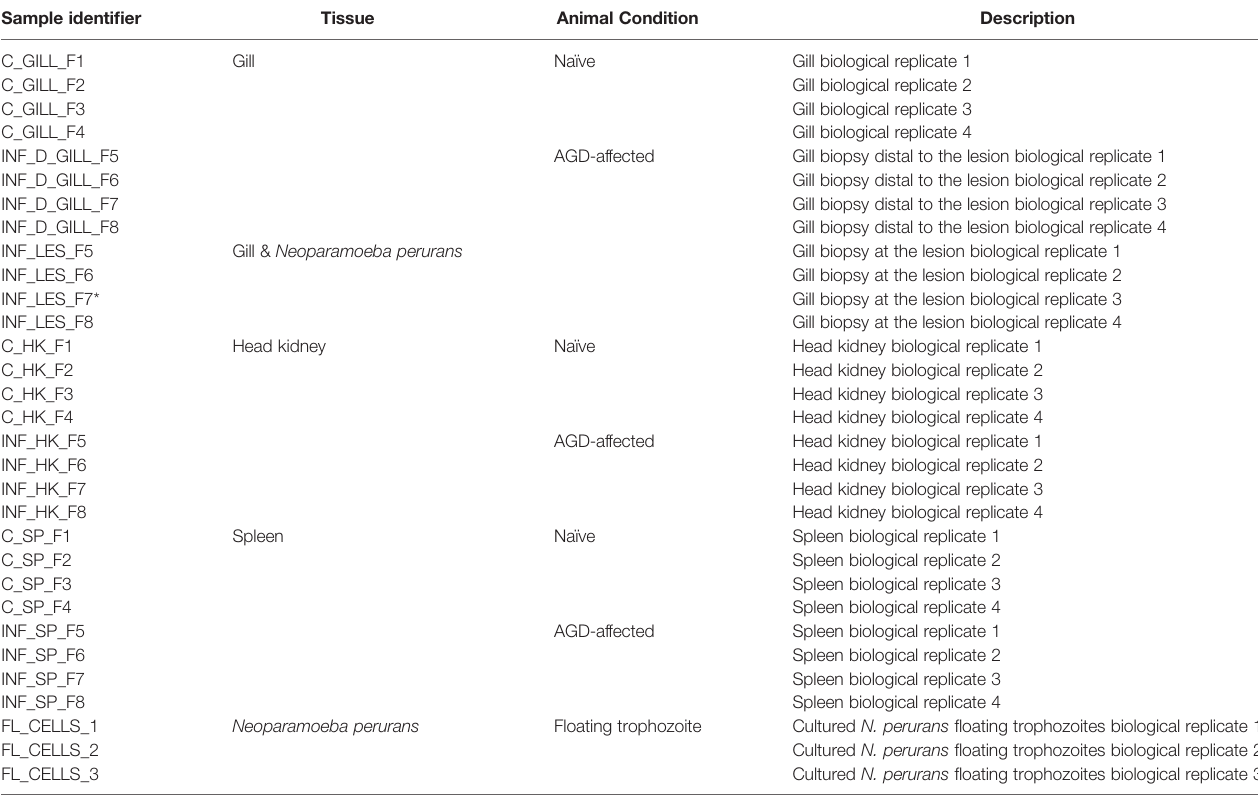
TABLE 1 | Attributes of samples collected in this study. Sample identi fi er